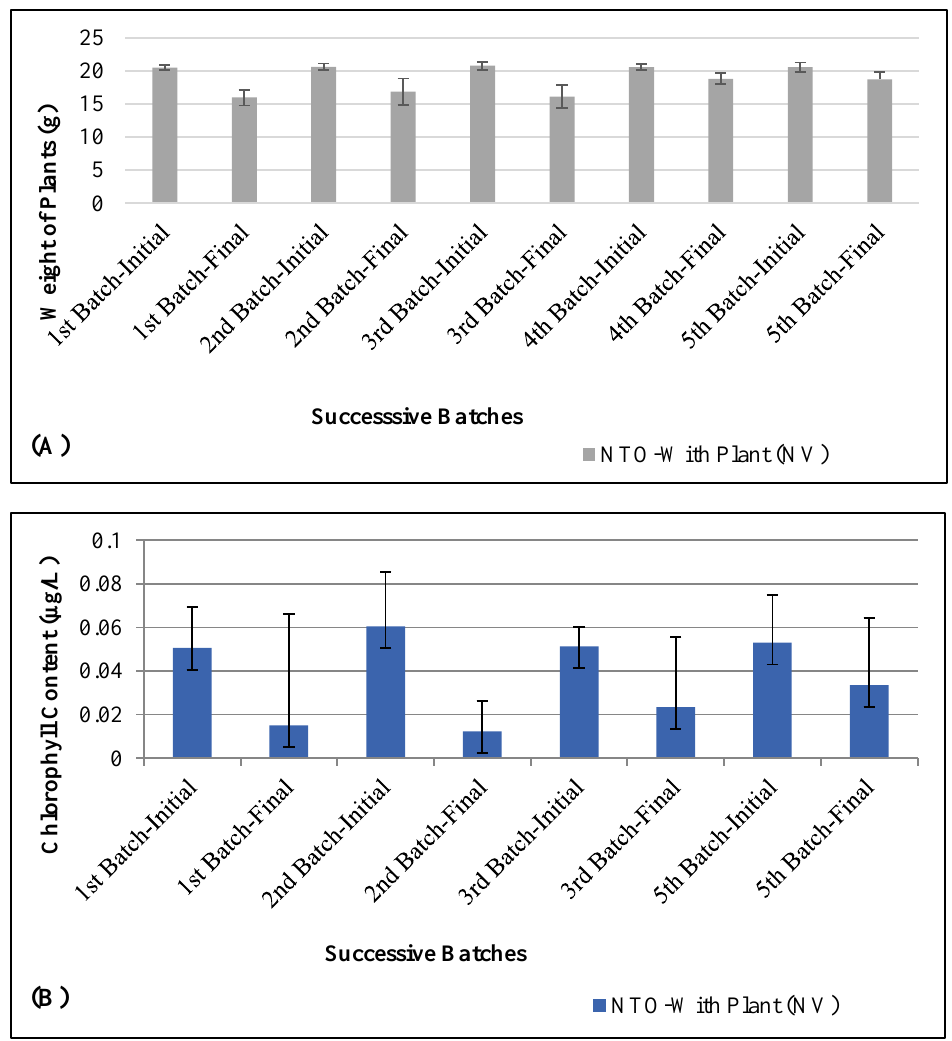
Figure 3. Phytotoxicity of NTO on vetiver grown in NTO-wastewater. ( A ) Plant biomass, ( B ) chlorophyll content. Successive batches of vetiver plants were introduced every 20 days. At the end of each successive batch, on average, vetiver lost 16.07 ± 6.83% (±SD) of its initial biomass in NV treatments. A significant loss in chlorophyll content was observed in vetiver in NV treatments for all batches. An average chlorophyll reduction of 60.18 ± 18.79% (±SD) was noted for the four successive batches.